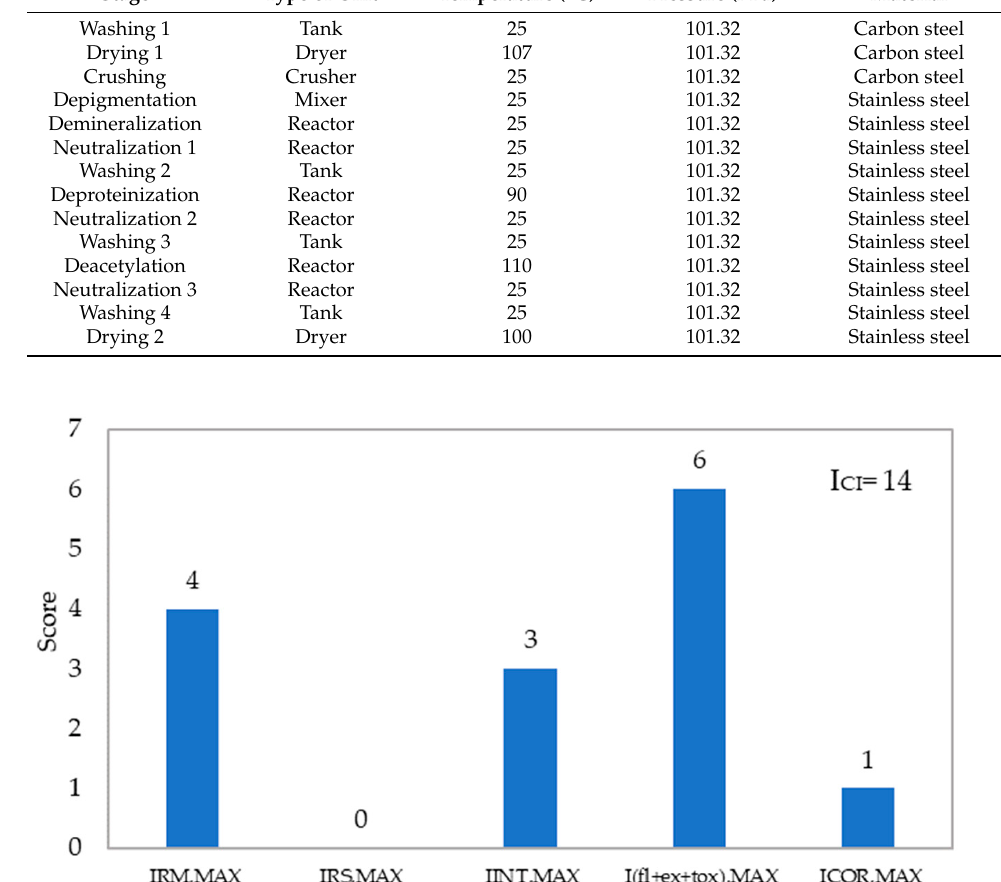
Figure 4. Subindices and total score for chemical inherent safety index.